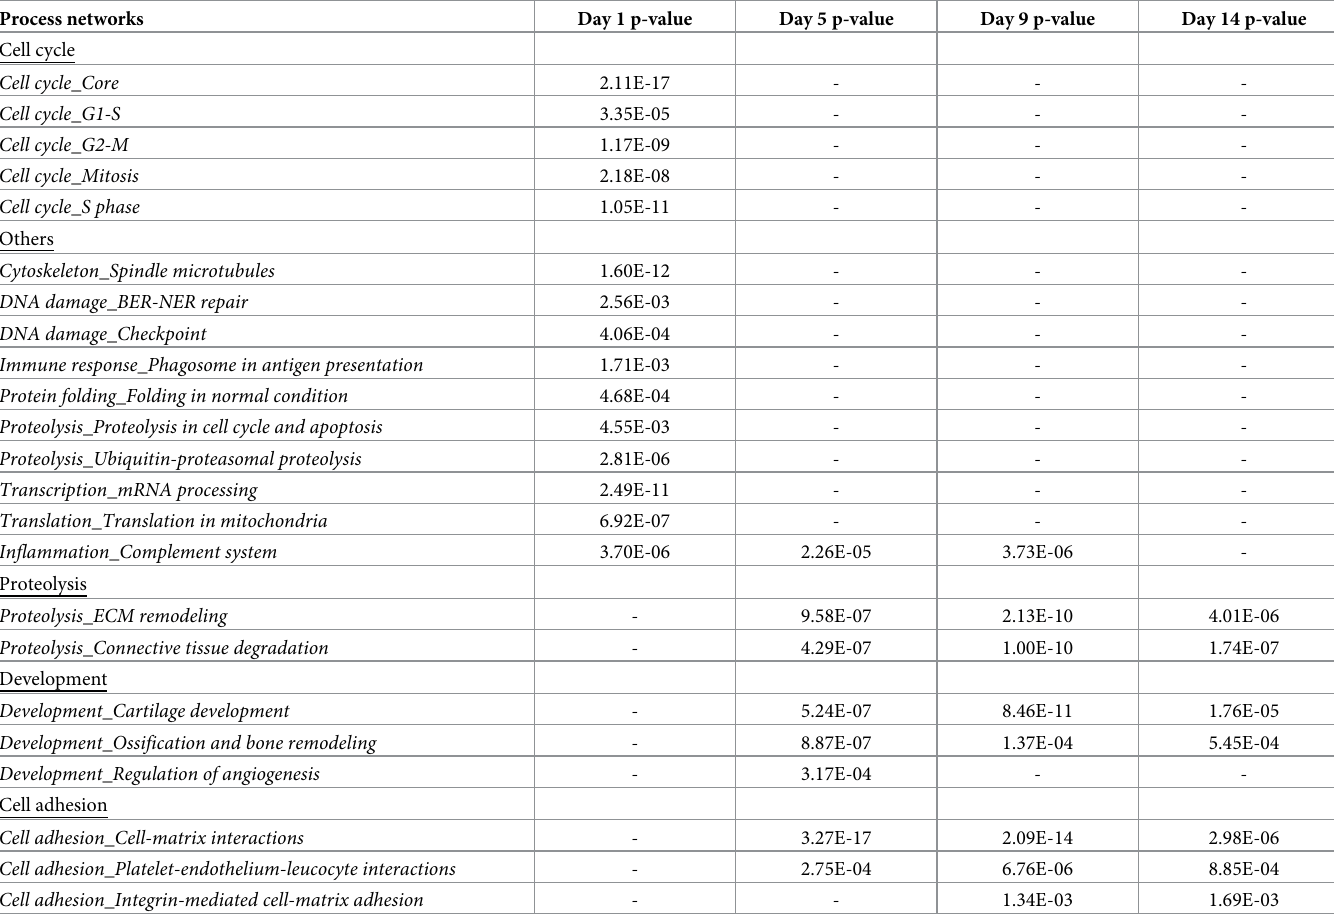
Table 2. Process network enrichment in synovium following joint